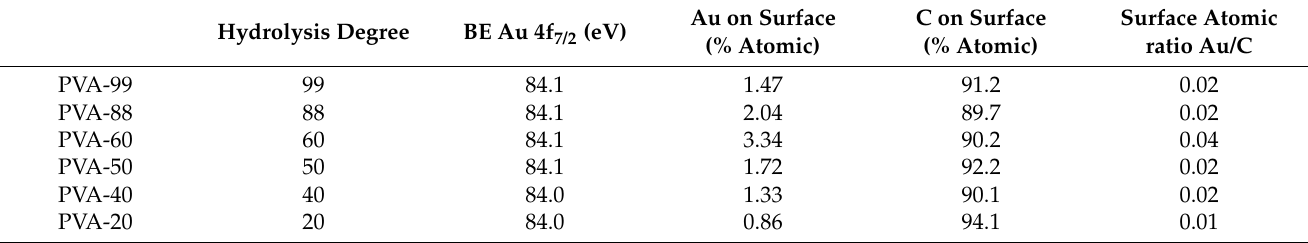
Table 5. X-ray photoelectron spectroscopy (XPS) data for 1% wt. Au/AC synthesized using PVA-2 (M n = 13,000–23,000) with different hydrolysis degrees.